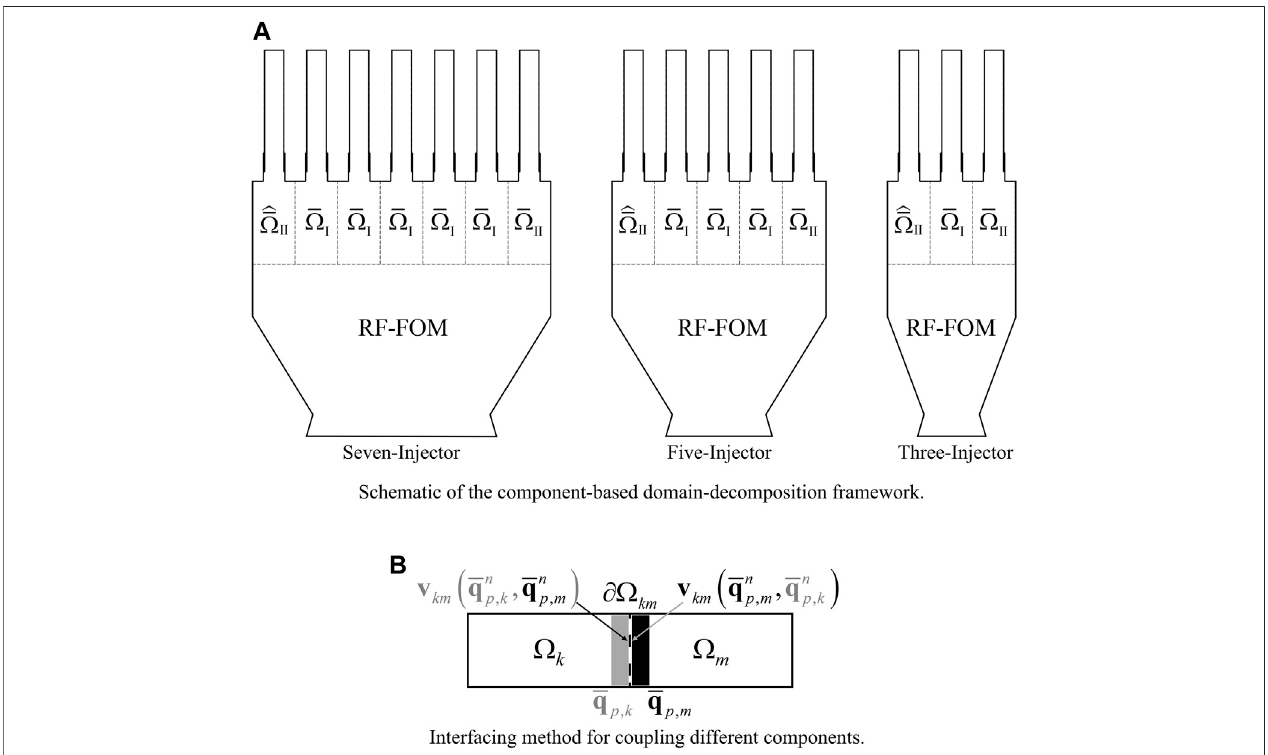
FIGURE 3 | Illustration of the component-based domain-decomposition framework. (A) Schematic of the component-based domain-decomposition framework. (B) Interfacing method for coupling different components.